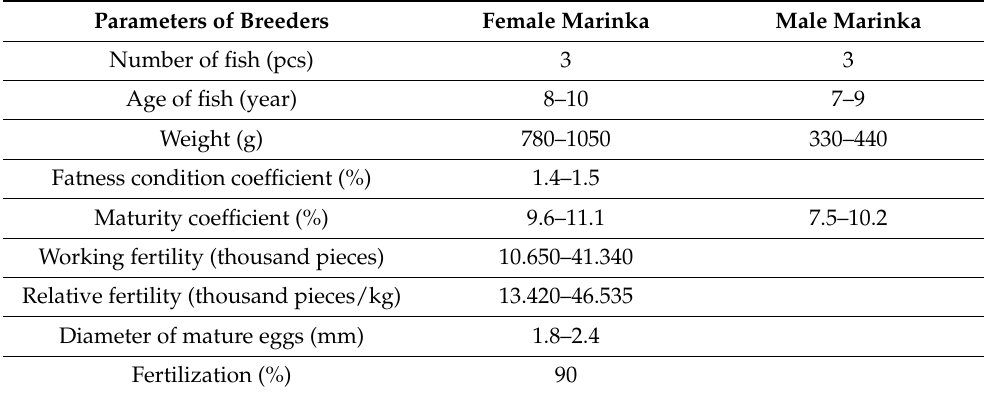
Table 5. Fish and biological indicators of breeders of Balkhash marinka in natural habitat.